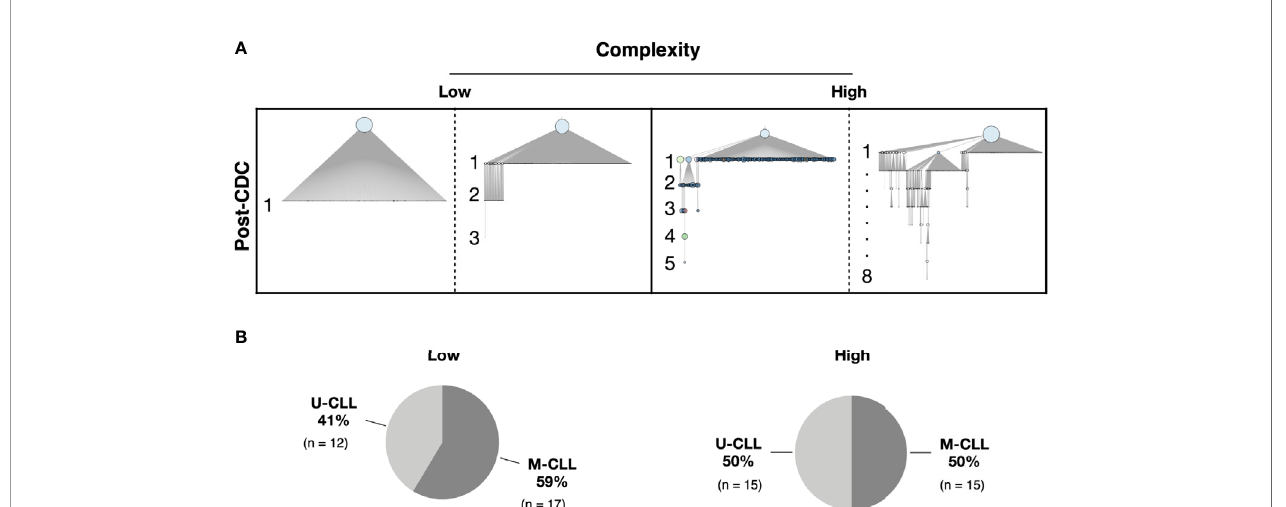
FIGURE 1 | Complexity of intraclonal IGHV-D-J variants. (A) Examples of the degree of intraclonal diversity in CLL samples based on NGS sequencing data. The phylogenetic trees were inferred with the R package Alakazam and plotted with igraph (see Methods ). The size of the CDC (light blue circles at top of each example) is proportional to its abundance within the entire leukemic clonal family. IGHV-D-J complexity is de fi ned and represented by the number of distinct sequences downstream of the CDC. Each downstream sequence has all the mutations of the upstream sequence plus at least one additional. Low complexity contains one to three mutation-de fi ned sequences downstream of the initial branch from the CDC. High complexity represents four or more unique sequences downstream of each initial branch, some involving intricate branching. (B) Pie graphs indicating the representation of U-CLL and M-CLL cases in the Low and High complexity categories.